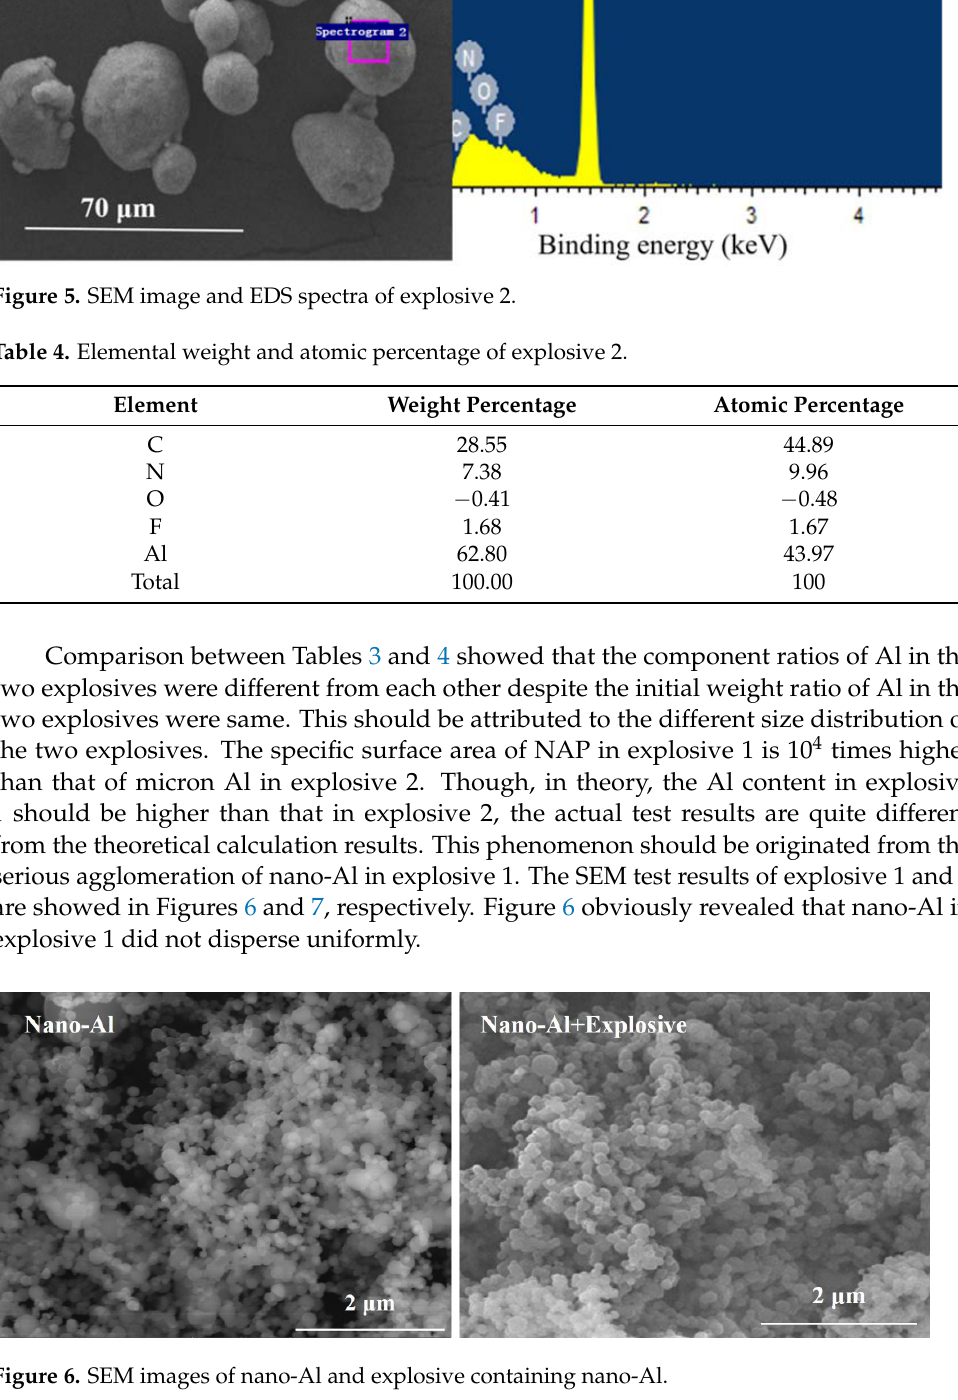
Figure 7. SEM images of micron-Al and explosive containing micron-Al. Comparison of Figures 6 and 7 showed that the diameter of nano-Al was much smaller than that of micron-Al despite both of them showing perfect spherical morphol- ogy. On the other hand, it is also clearly shown that the aggregation of nano-Al was more serious than that of the micron-Al. The dispersion of nano-Al in RDX is also influenced by the aggregation of nano-Al. The micron-Al dispersed more evenly than the nano-Al. 3.2. Test and Analysis of Surface Energy and Adhesion Work of Materials To further investigate the surface characteristics between nano-Al/micron-Al, RDX and paraffin wax, the four reagents are tested by the probe method. The obtained results are listed in Table 5. Table 5. Surface energy of each explosive component. Reagent